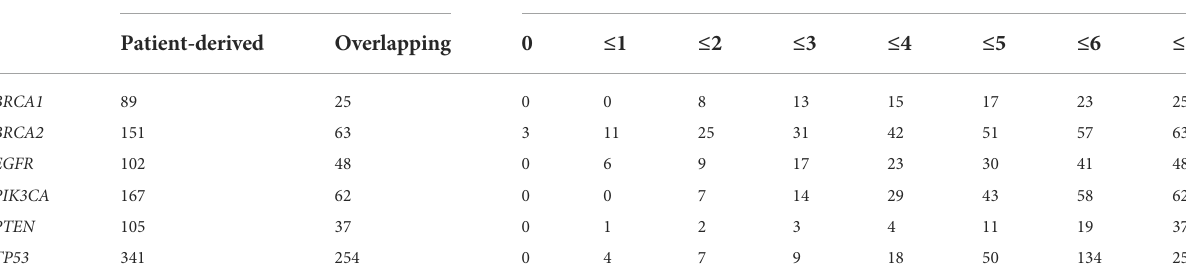
TABLE 2 Number of SNPs that were scored in the prediction framework and matched with SNPs reported from breast cancer patients in the